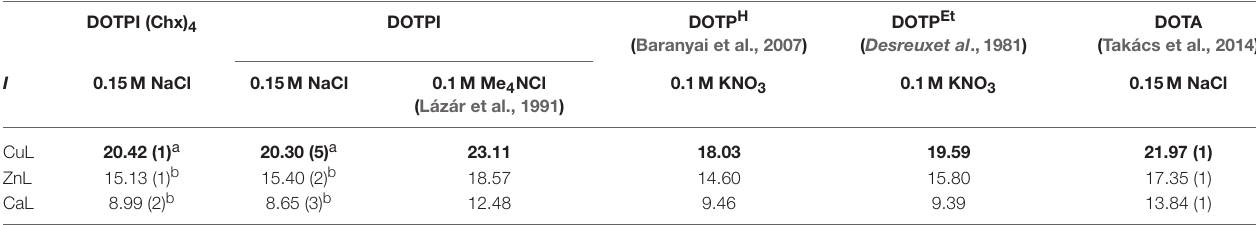
TABLE 2 | Stability constants (log K ML ) for non-protonated DOTPI(Chx) 4 , DOTPI, DOTP H , DOTP Et , and DOTA complexes formed with divalent metals at 25 ◦ C, determined by UV/Vis spectroscopy (a) or potentiometry (b). DOTPI (Chx) 4